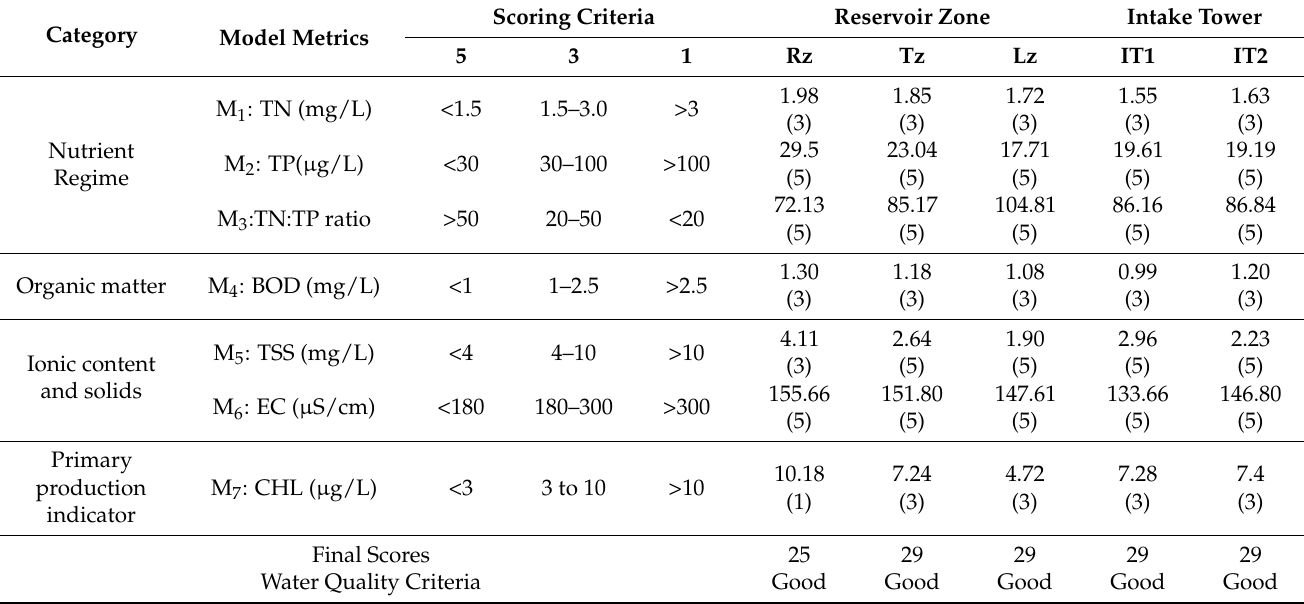
Table 4. Chemical health assessment of Daecheong Reservoir using multi-metric water pollution index (WPI) during